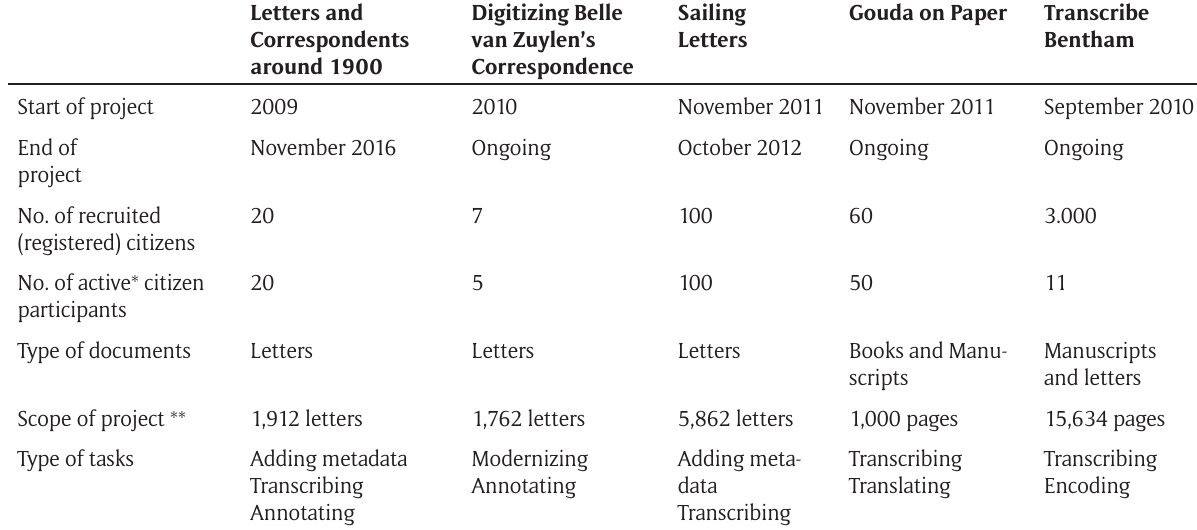
Table 1: Overview of the cases at the time of the study